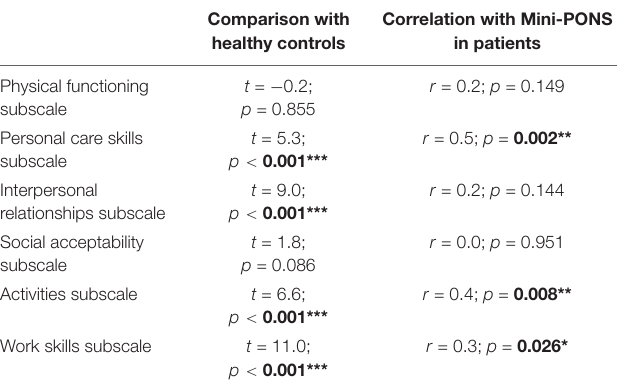
TABLE 4 | SLOF subscales comparison between schizophrenia patients and healthy controls; SLOF subscales correlation with Mini-PONS total score controlling for medication in schizophrenia